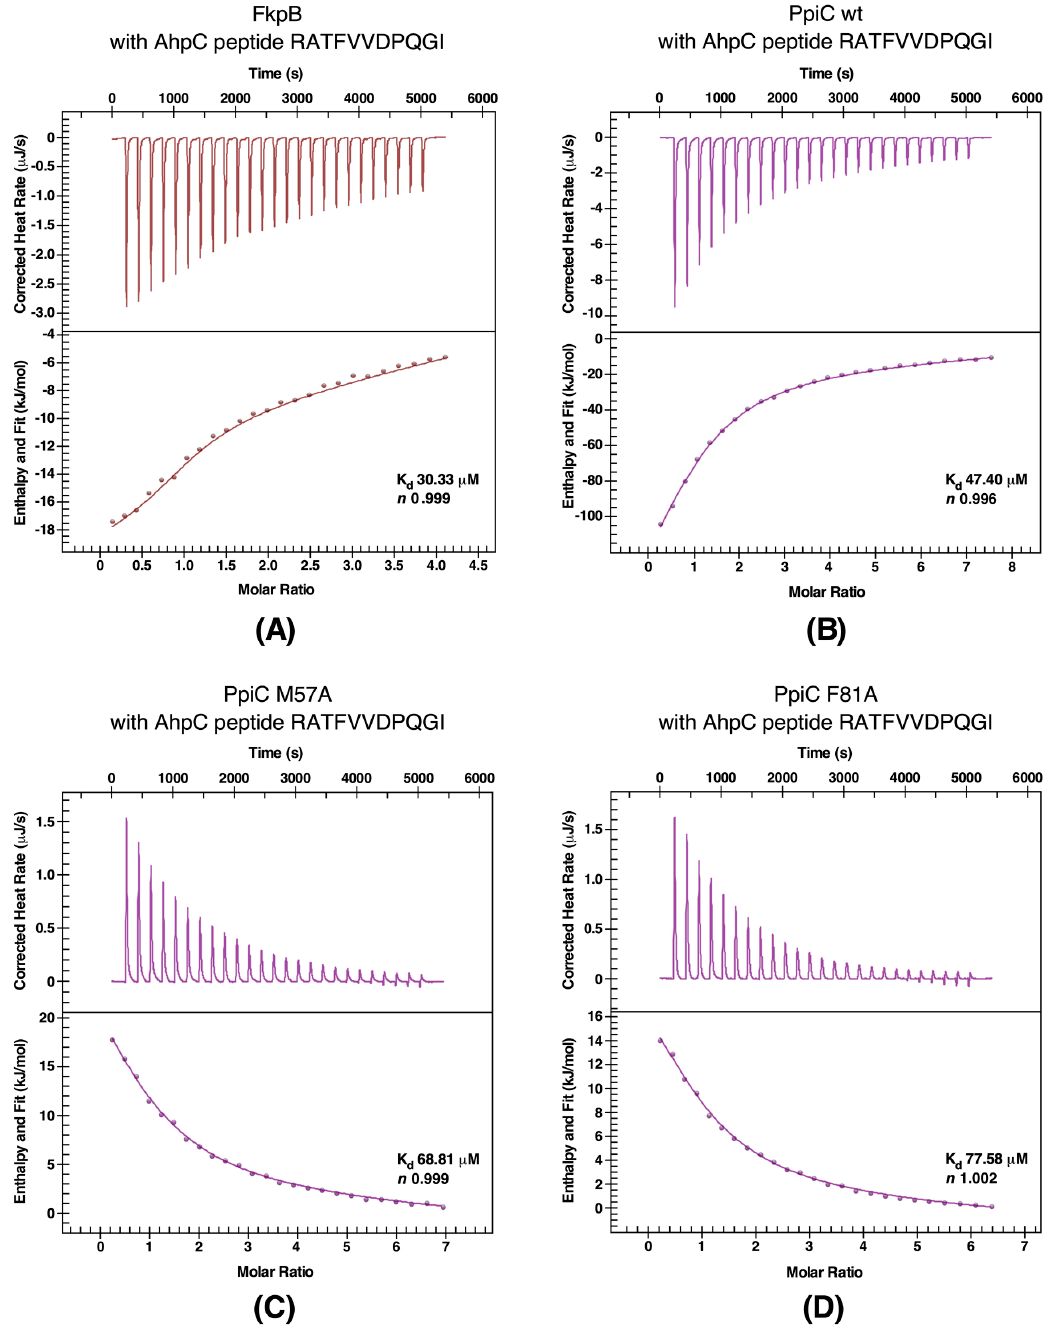
Figure 9. ITC experiments with the AhpC ‐ derived peptide and FkpB (Panel A ) and PpiC wild ‐ type (Panel B ) and PpiC M57A (Panel C ) and PpiC F81 (Panel D ). Heat rates and fit for ITC experiment, and the calculated stoichiometry ( n ) and dissociation constant ( K d ) are indicated in insets.